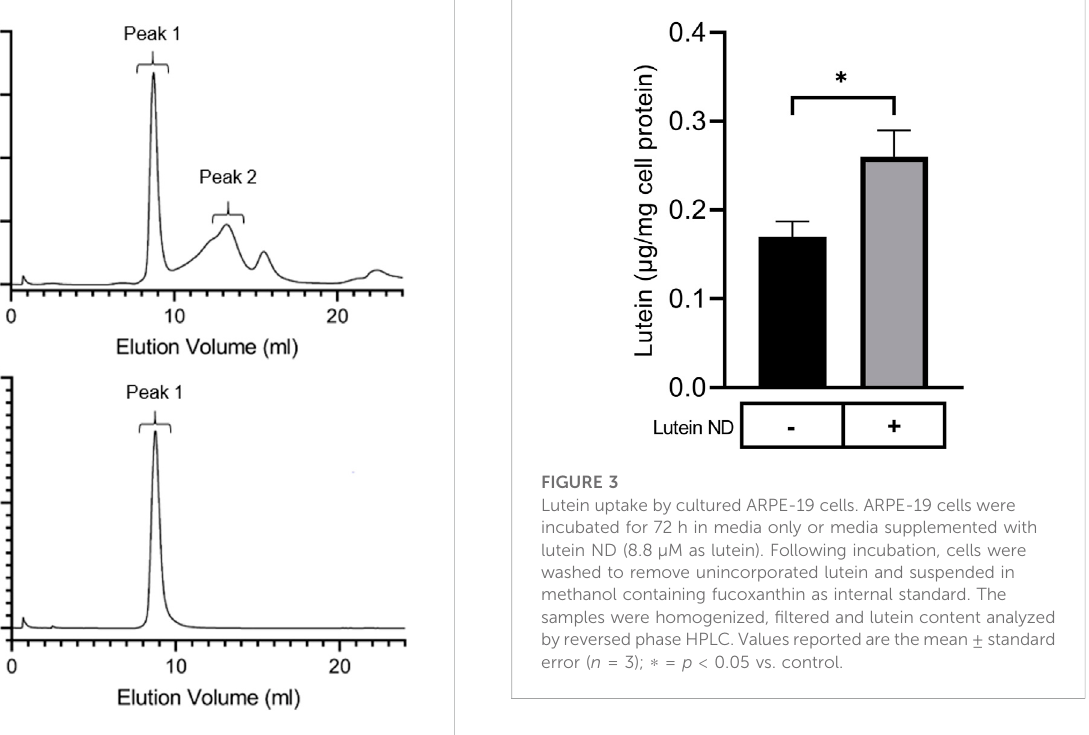
FIGURE 2 FPLC gel fi ltration chromatography of lutein ND. A 400 μ l aliquot of freshly prepared lutein ND (corresponding to 0.8 mg apoA-I and 0.4 mg lutein) was analyzed by FPLC gel fi ltration chromatography, with absorbance continuously monitored at 280 nm (A) . Fractions corresponding to Peak 1 from Panel a were pooled, concentrated and subjected to FPLC gel fi ltration analysis under the same conditions (B) .